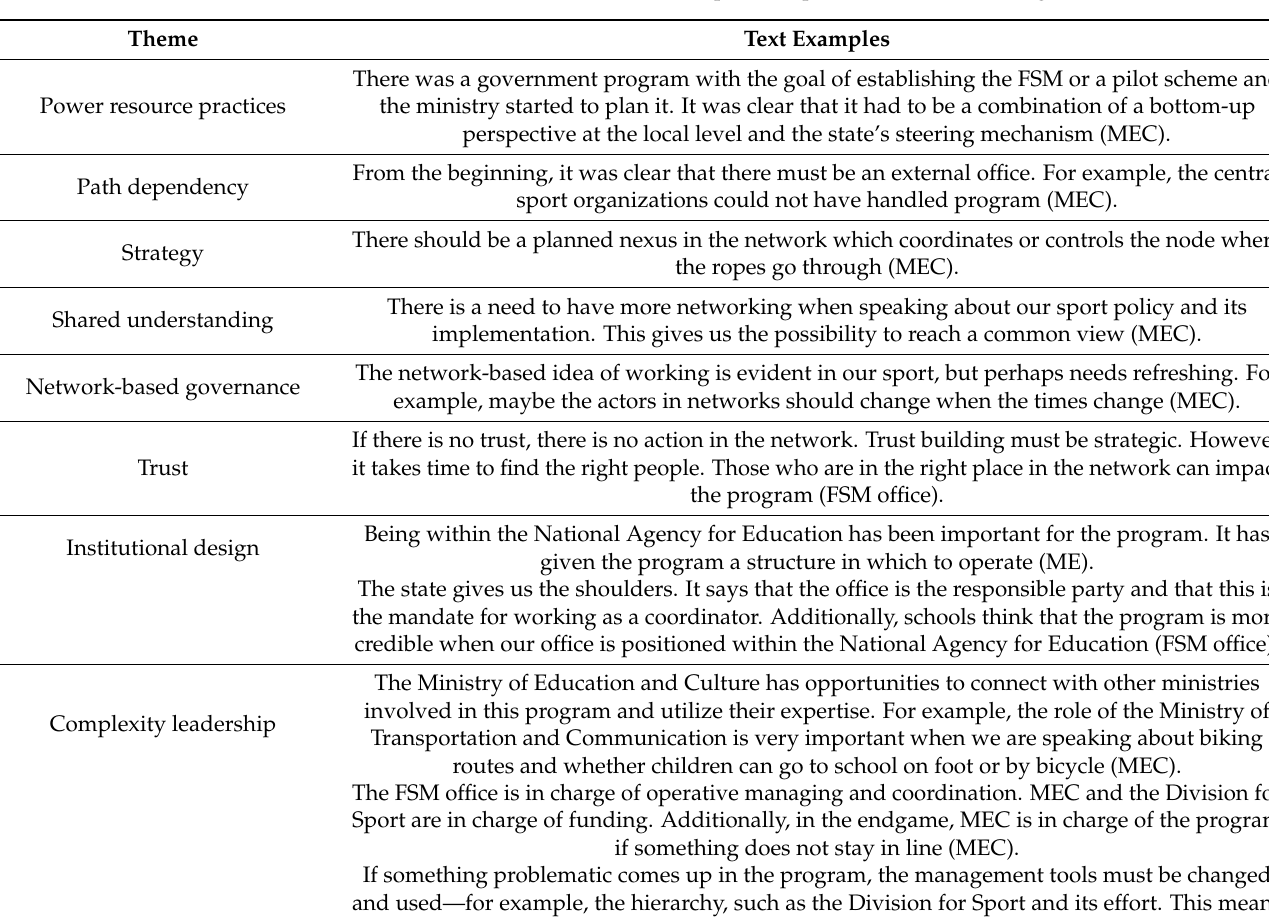
Table 2. Themes identified in the interviews, with selected text examples (adapted from Finnish to English) for illustration. Theme Text Examples Power resource